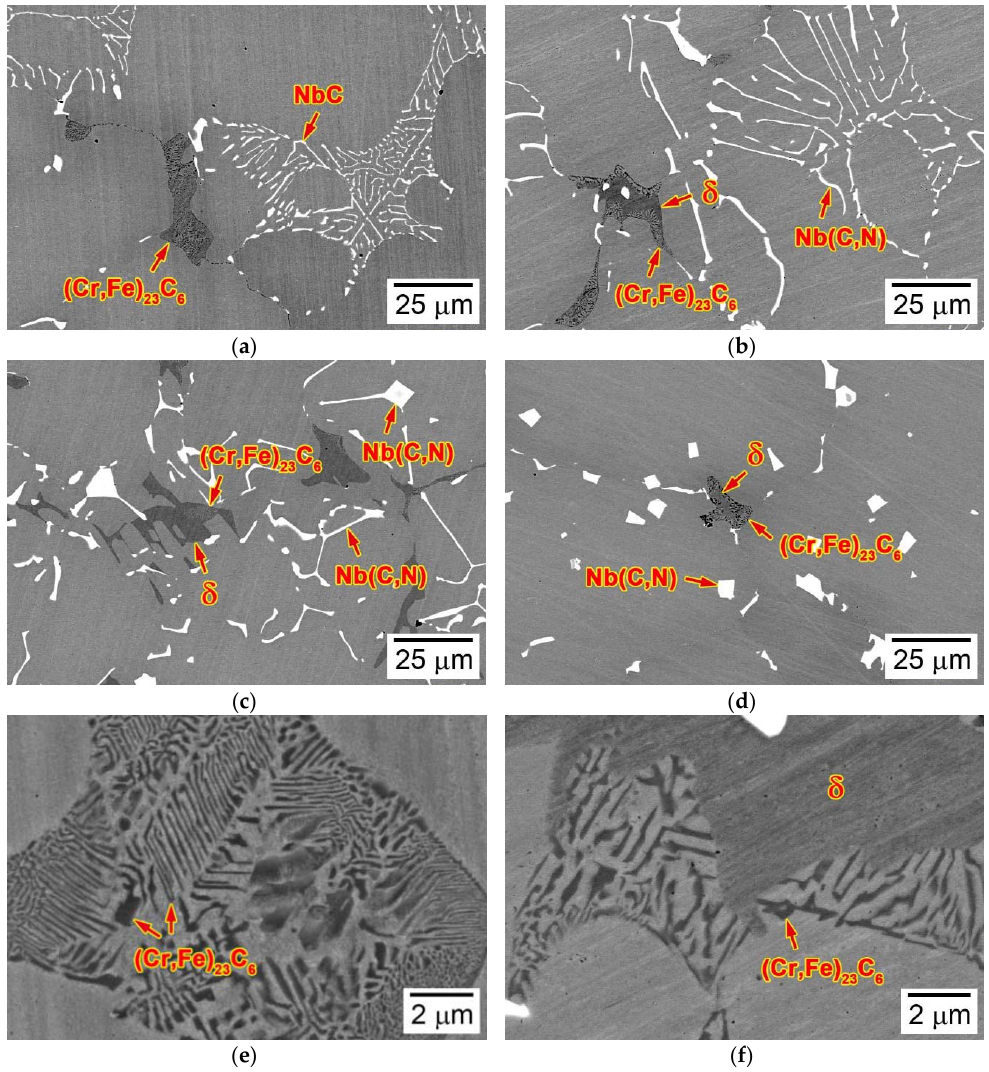
Figure 2. SEM-BSE images showing the typical microstructures of as-cast alloys ( a ) 4C0N, ( b ) 3C2N, ( c ) 2C2N, and ( d ) 2C4N; ( e ) and ( f ) are enlarged SEM-BSE images of typical (Cr,Fe) 23 C 6 carbide acquired from Figure 2a,b, respectively.